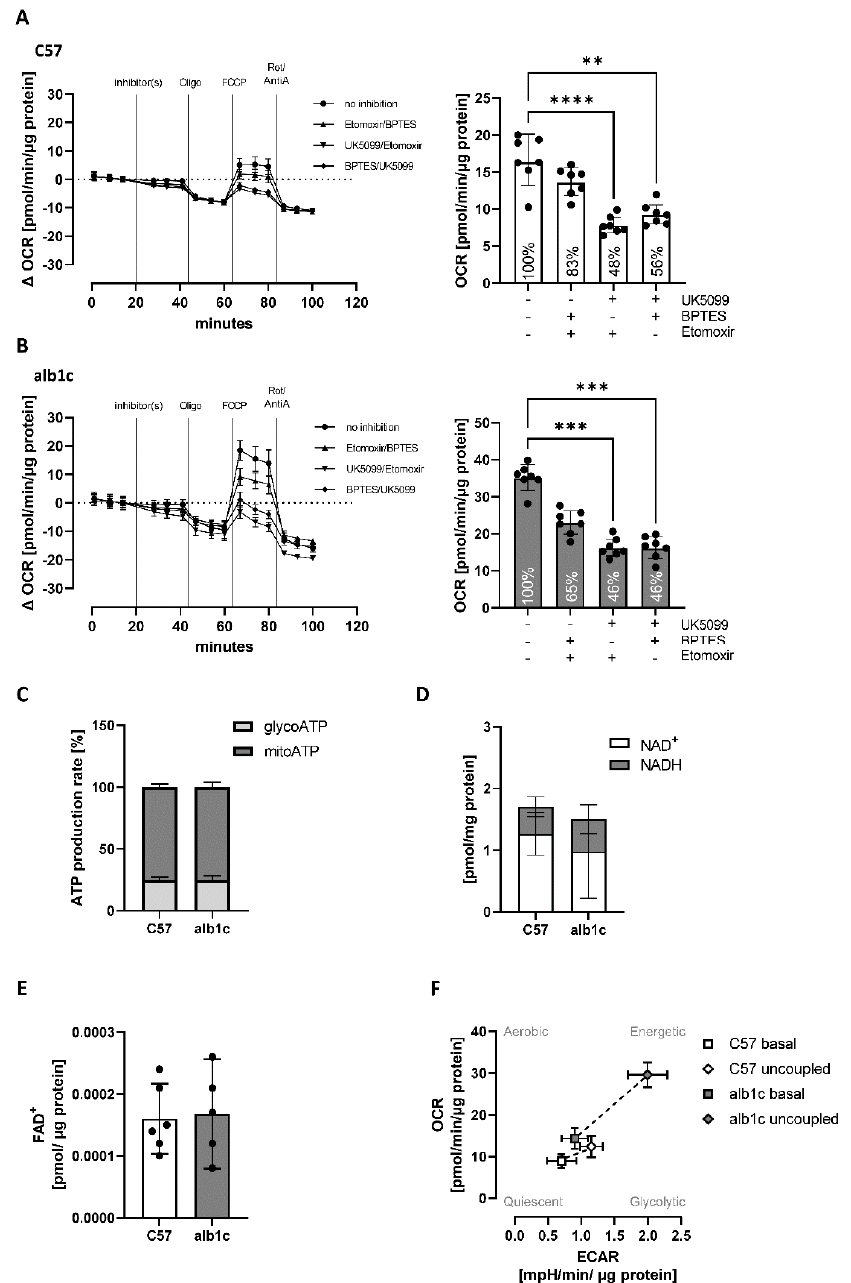
Figure 8. Substrate oxidation preferences and energetic profile of mitochondrial activity in SREBP-1c-forced early-stage MAFLD. ( A , B ) Substrate oxidation was measured by extracellular flux analyses in the absence or presence of the inhibitors UK5099, BPTES, and etomoxir to force substrate utilization specifically through glucose (etomoxir/BPTES), glutamine (UK5099/etomoxir) or long-chain fatty acids (UK5099/BPTES). Assay profiles for ( A ) C57Bl6 vs. ( B ) alb-SREBP-1c hepatocytes and calculated maximal oxygen consumption rates (OCR) for each condition tested are shown (bar charts). ( C ) ATP production rates were calculated as a percentage of the whole ATP production in primary hepatocytes from both phenotypes. ( D ) NAD + and NADH as well as ( E ) FAD + abundance were measured in mitochondrial fractions isolated from liver tissue of both phenotypes. ( F ) Energy phenotypes were assessed by measuring OCR vs. extracellular acidification rate (ECAR) in the primary hepatocyte culture from alb-SREBP-1c vs. C57Bl6 livers in basal and uncoupled states. Data are expressed as mean ( ± 95% CI or ± SD (F), n = 5–12 per group—depending on assay). Statistics: ANOVA with Kruskal–Wallis test, ** p < 0.01, *** p < 0.001 **** p <